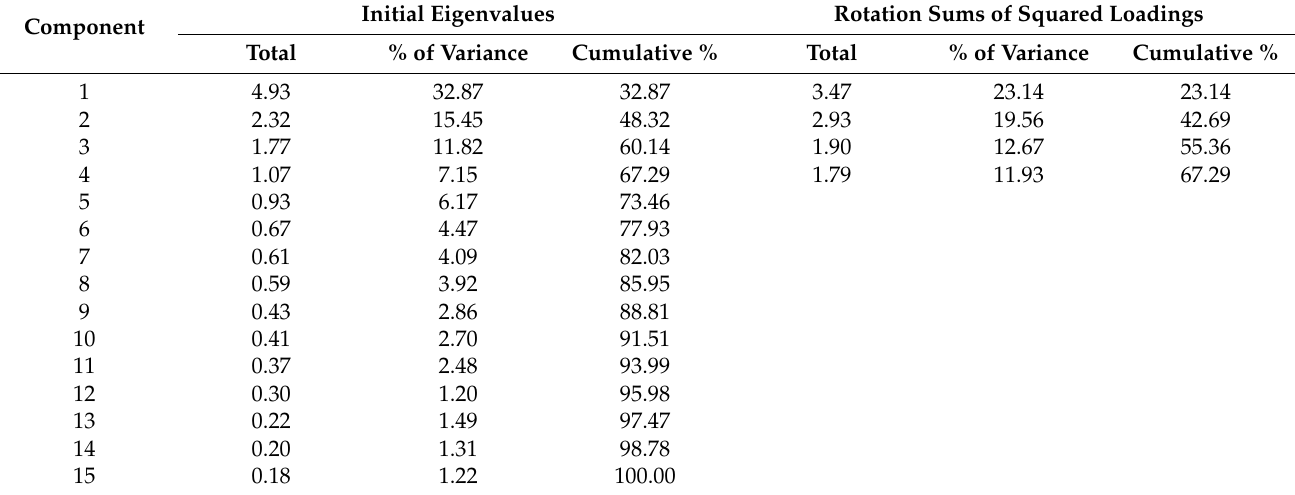
Table 5. Success Factors Total Variance